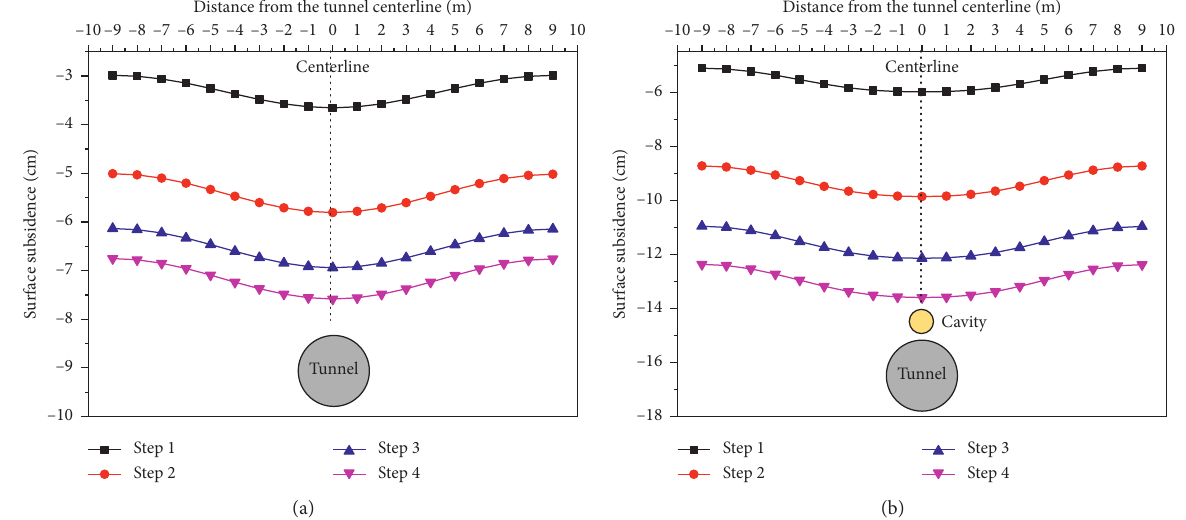
Figure 17: Surface subsidence curve of numerical simulation. (a) Without cavity. (b) With